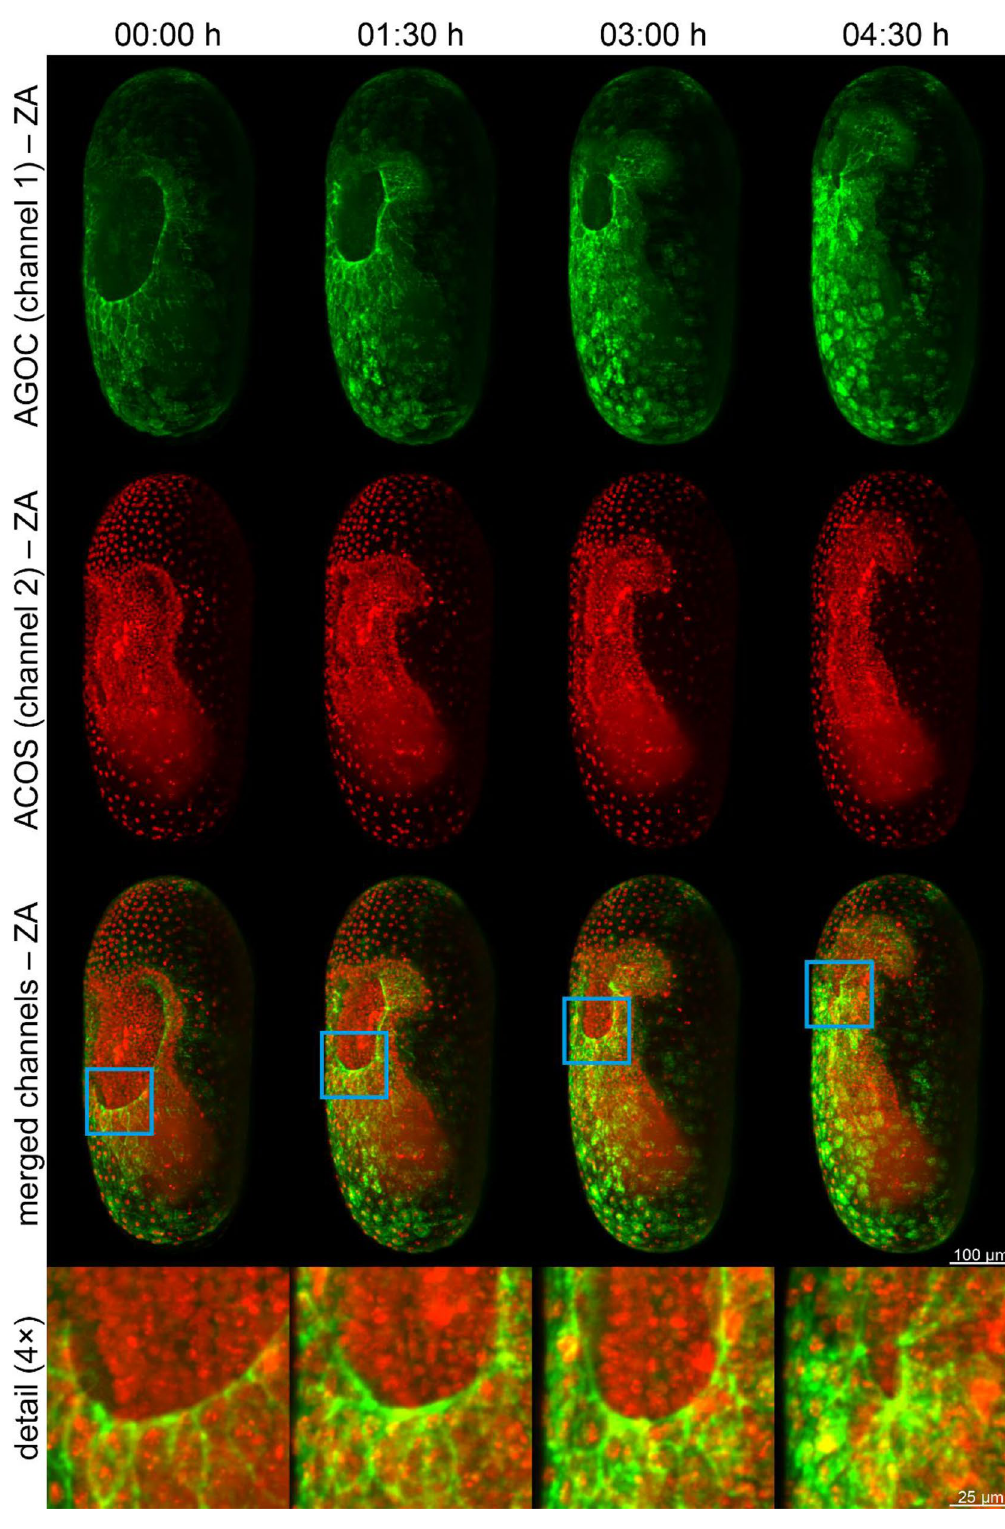
Figure 2. Fluorescence live imaging of a (mO/mO; mCe/mCe) double homozygous Tribolium embryo from the Gruul #1 hybrid subline during gastrulation. The tissue-specific expression of mEmerald-labeled Lifeact (green, first row) visualizes the actin cytoskeleton in the extra-embryonic serosa cells, while mRuby-labeled histone H2B (red, second row) visualizes cell nuclei. This hybrid subline provides essential data for investigations of the complex morphogenetic dynamics of embryonic and extra-embryonic tissues during serosa window closure (third row and detail images). ZA, Z maximum projection with intensity